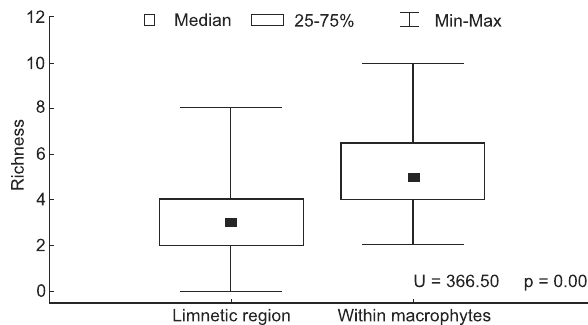
Figure 2. Median ± minimum maximum values of species richness between zooplankton and macrophytes samples.